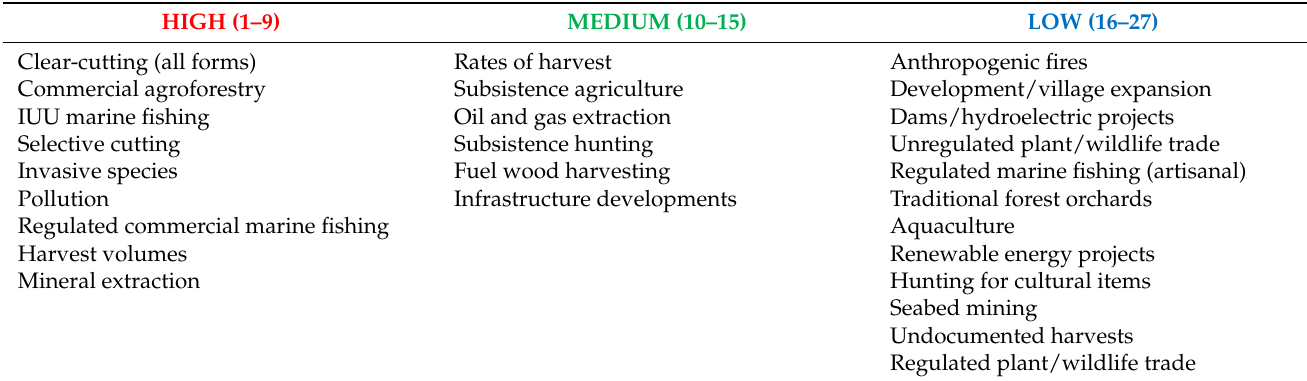
Table 1. Hierarchical listing of specific biodiversity threats in Papua New Guinea based on quantitative SWOT and multivariate cluster analyses. Heading colors and numbers (e.g., HIGH 1–9) correspond to those of the cluster analysis dendrogram (Figure 3). Threat nomenclatures and associated definitions are in Appendix